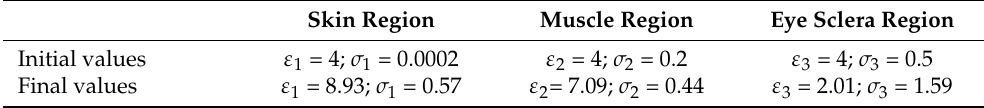
Table 4. Poynting vector for the reference model and the simplified